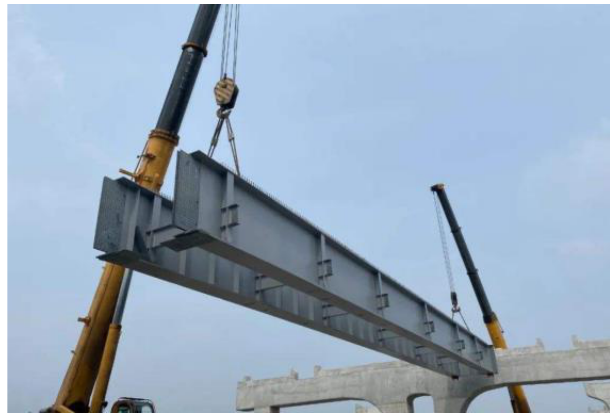
Figure 1. Steel plate girder in long-span structures.